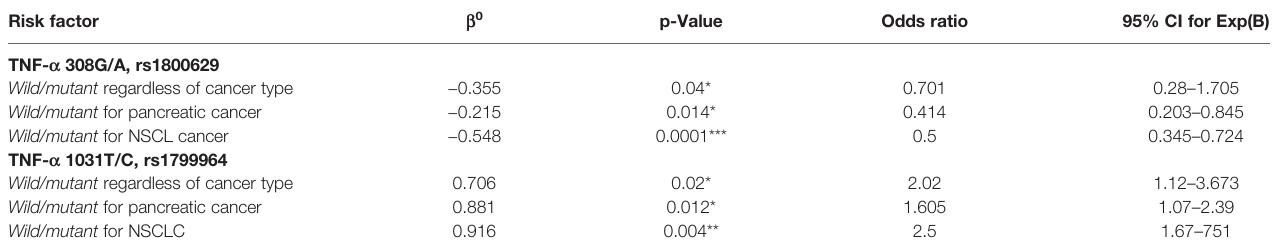
TABLE 4 | Risk factors for cachexia associated with cancer by binary logistic regression analysis. Risk factor